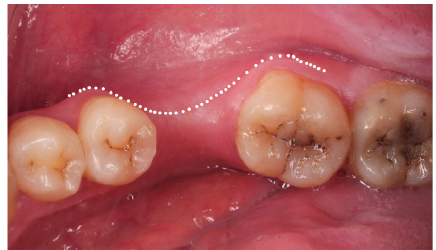
Figure 1: Preoperative occlusal view showing insufficient attached zone around the edentulous